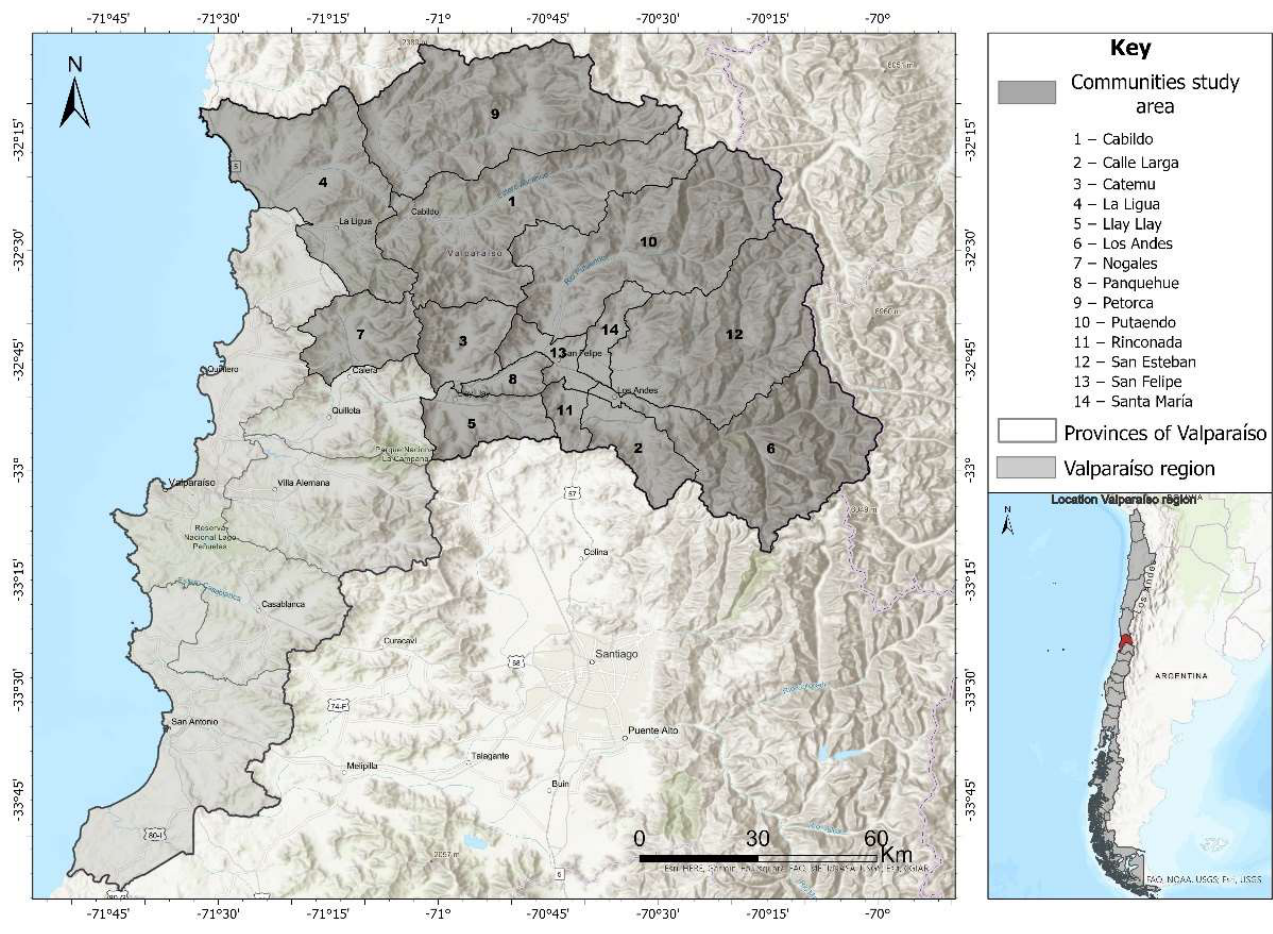
Figure 2. Map of the study area.